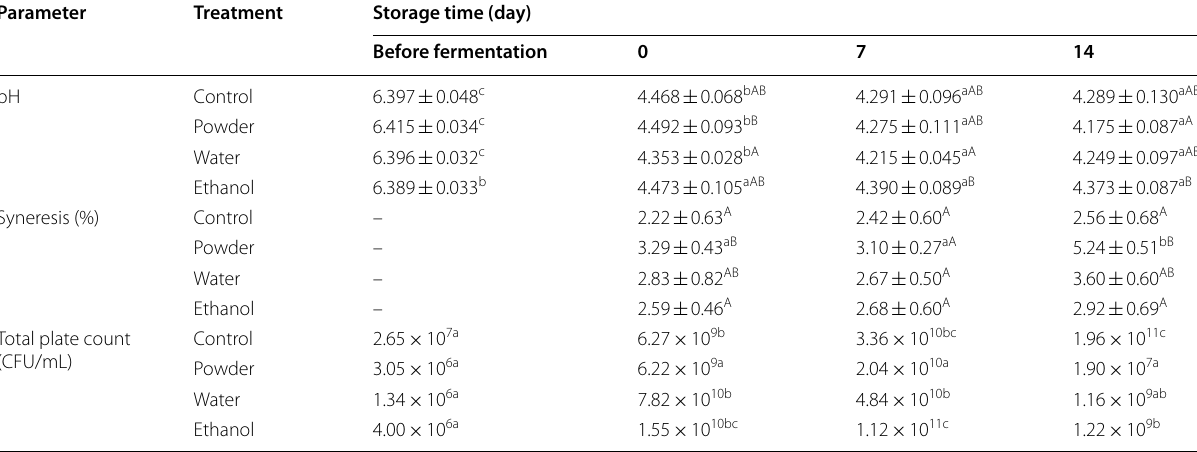
a– c Mean values in the same row with different letters are significantly different ( p < 0.05) A, B Mean values in the same column with different letters are significantly different ( p <